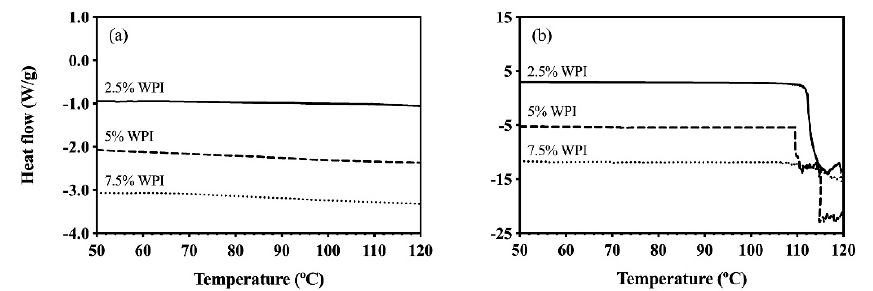
Figure 2. DSC thermograms of the samples with different protein concentrations: ( a ) CD samples and ( b ) CE samples. Samples were processed under the thermal and mechanical conditions used for OC and HOC, respectively. The straight and dotted lines represent samples made with different WPI concentrations.